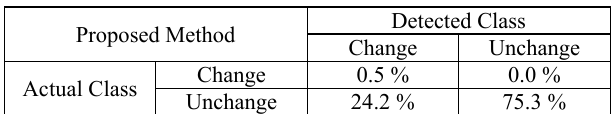
Table 2 . Results of the proposed method (depth image).